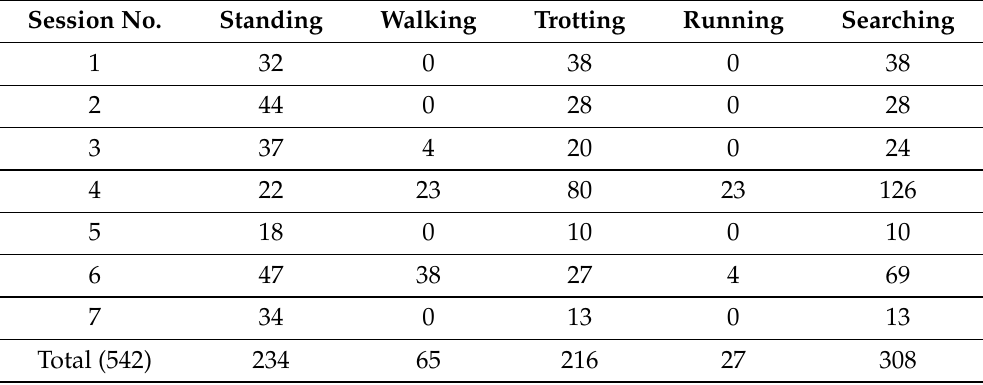
Figure 7. Sensor samples of 2 s duration for four activities. Table 4. Number of samples for each search and rescue session for four monitored